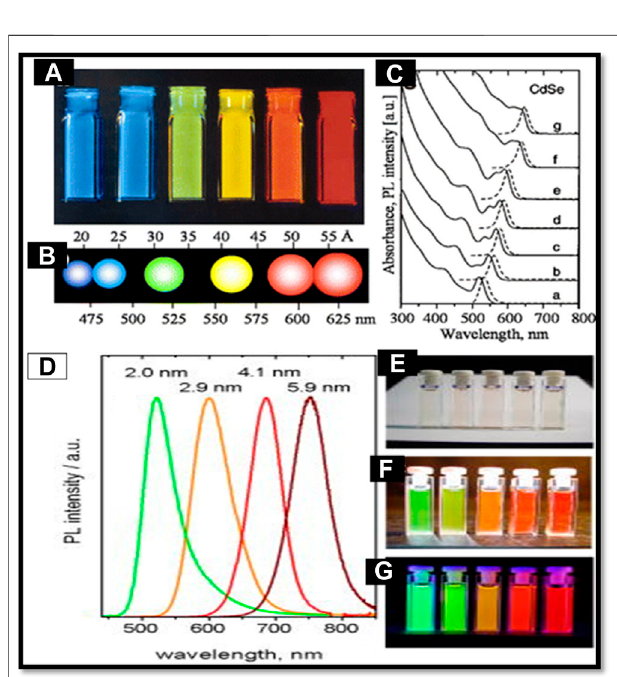
FIGURE 10 | (A,B) Image of CdSe QDs with different particle sizes and (C) theirsize-dependent absorptionand emission spectrum (Biju et al.,2008). (D) Spectrum and images of InP QDs under (E) ambient conditions, (F) white light, and (G) 366 nm UV light (Adam et al.,